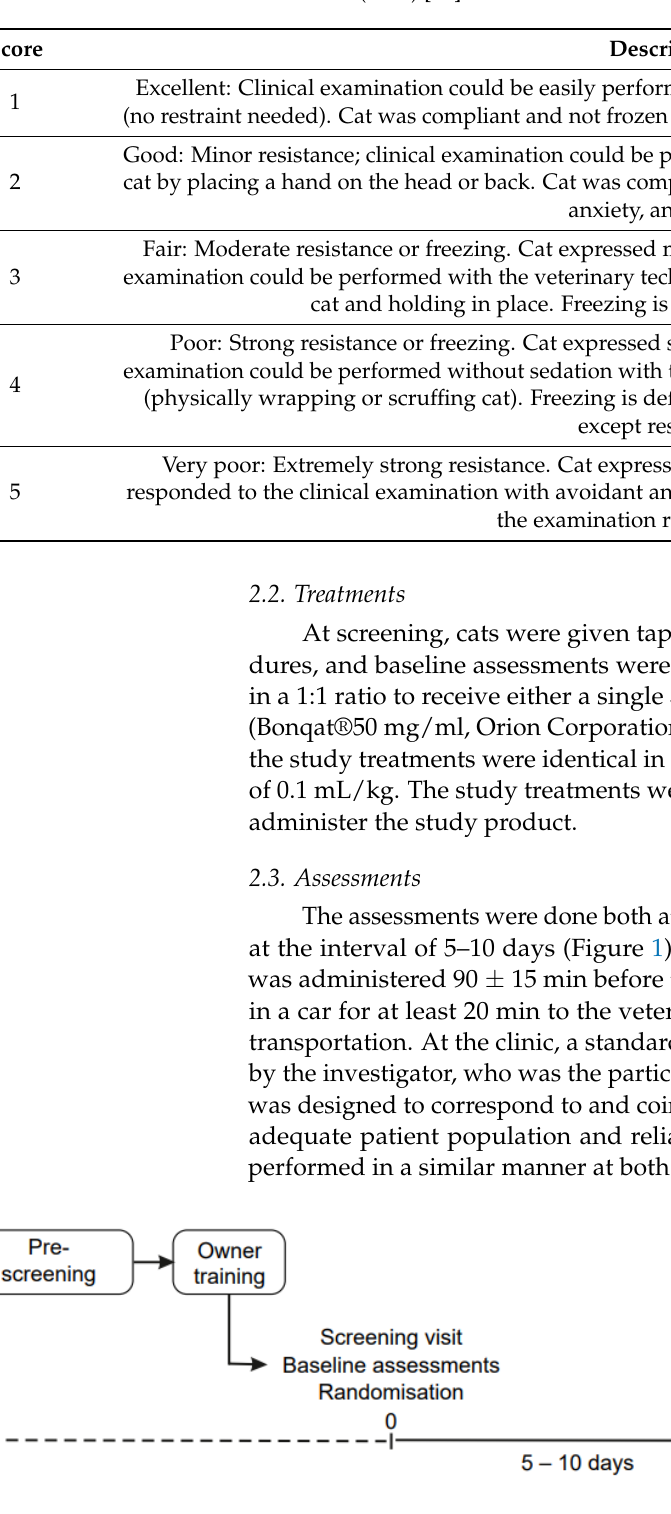
Figure 1. Study design of the clinical field